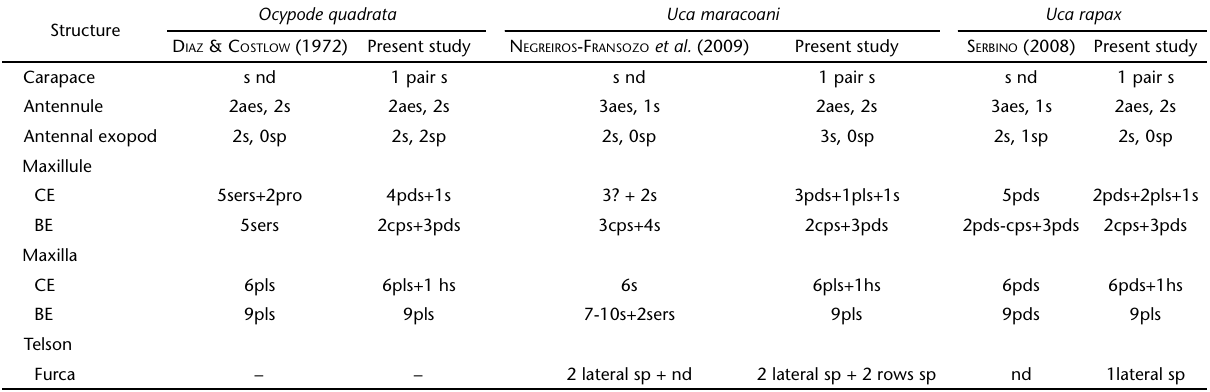
Table V. Morphological comparison between the present study and previous descriptions of Ocypode quadrata , Uca maracoani and Uca rapax .